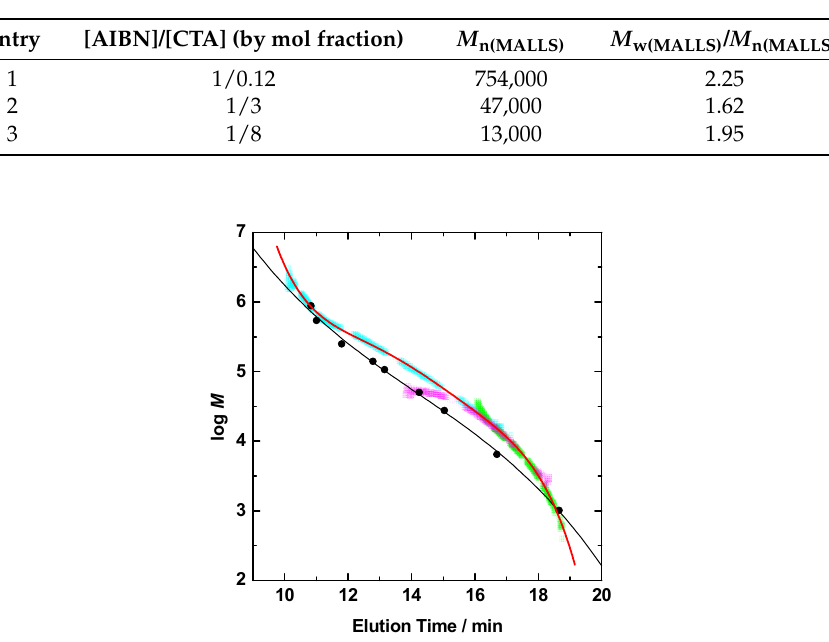
Figure 4. Calibration curves for the molecular weight calculation estimated with standard poly(ethyleneoxide)s (black circle) and molecular weights of poly(DEMM-TFSI) obtained from GPC-MALLS (red line). Molecular weights of poly(DEMM-TFSI) was calculated by the intercept of Zimm plots from the each SLS measurement at respective elution times (blue, pink, and green dots).